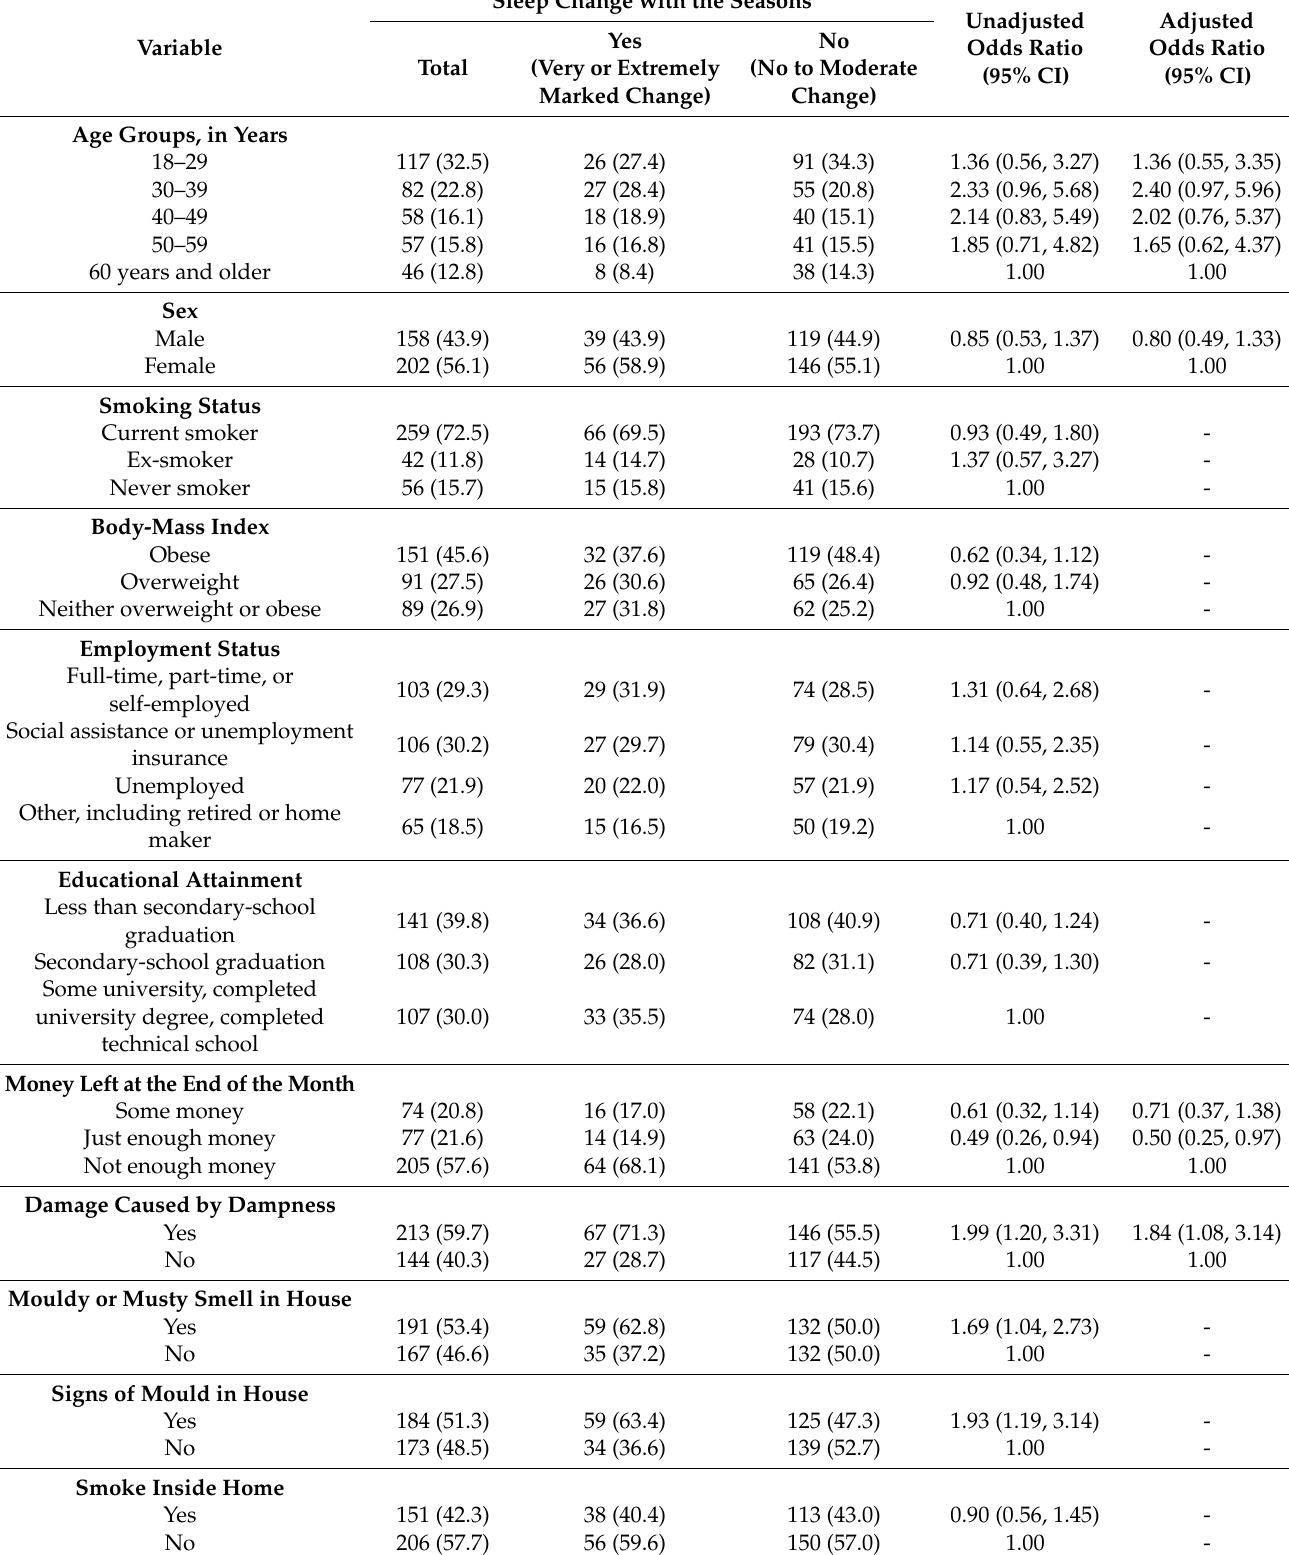
Table 5. Association among demographic, social, and environmental factors and sleep change with seasons ( n = 360).